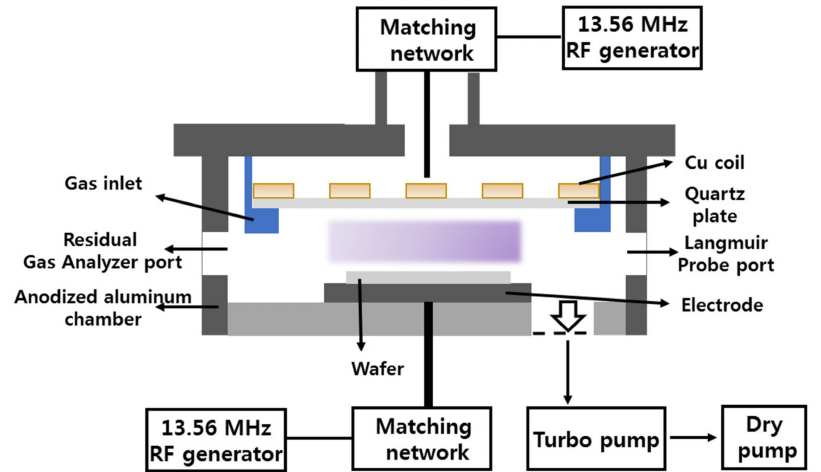
Figure 1. Schematic diagram of inductively coupled plasma (ICP) reactor with